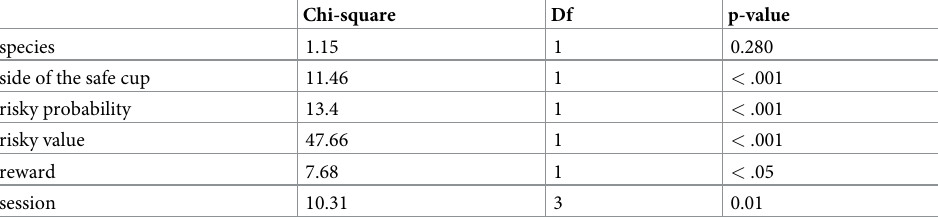
Table 4. Fixed effects of the final model investigating subjects’ risky preference in Experiment 2. The table reports the results of the analysis of deviance (type II Wald chi-square tests). Only trials with P < 1 were